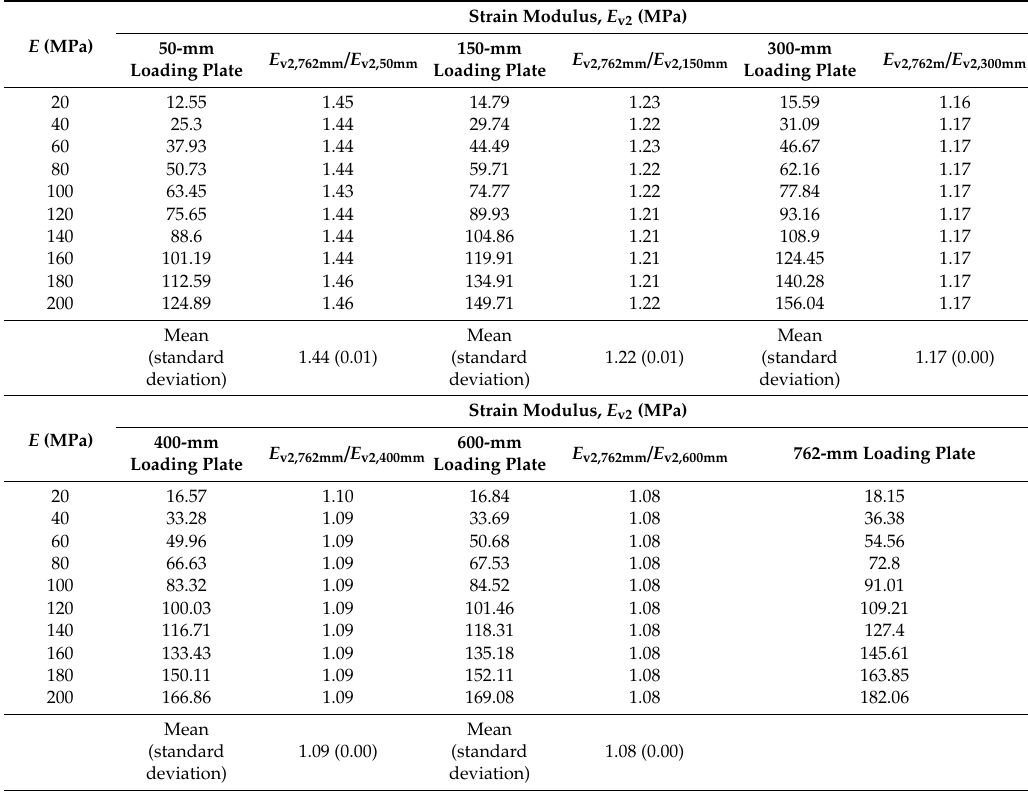
Table 5. Strain modulus according to the loading-plate size under the field-test roadbed